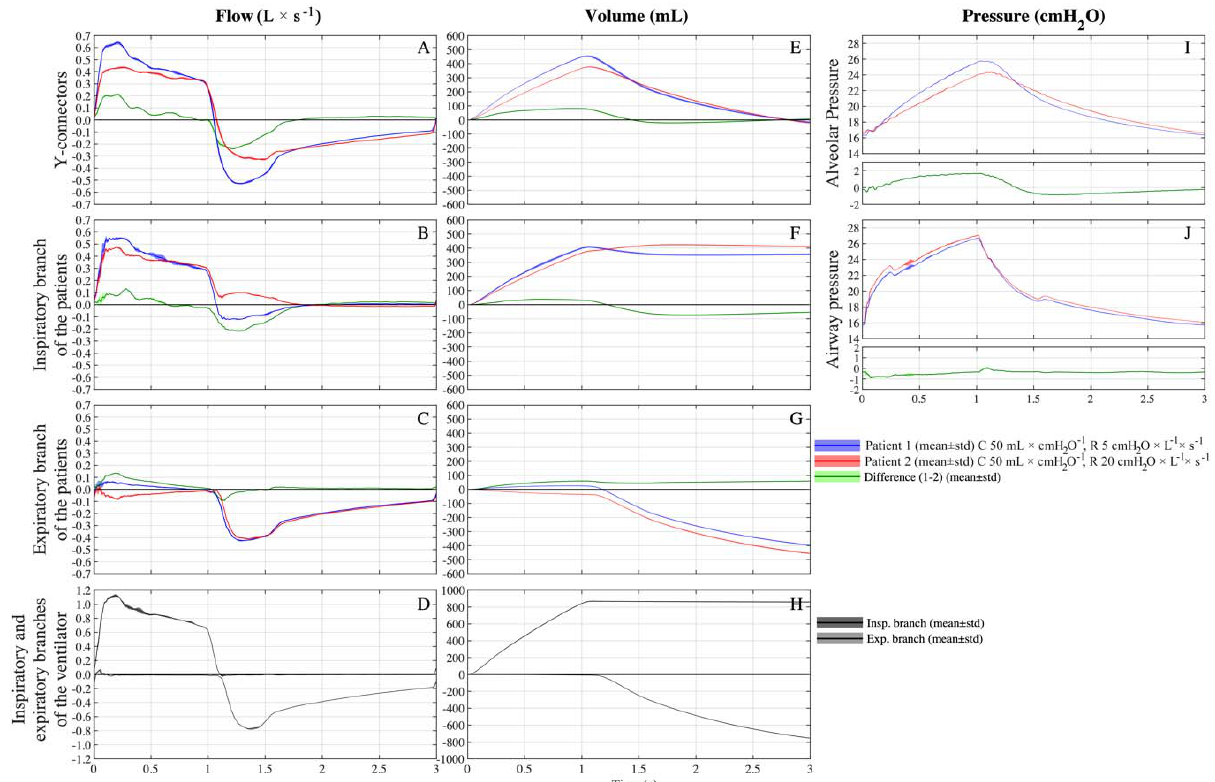
Figure 3. Average (continuous line) ± standard deviation (filled area plot) of multiple breaths of flows, pressures and volumes across the custom-made circuit on setting C 50-50/R 5-20 (C = 50 mL × cmH 2 O − 1 for both patients, R = 5 cmH 2 O × L − 1 × s − 1 for patient 1 and R = 20 cmH 2 O × L − 1 × s − 1 for patient 2). Blue = patient 1, red = patient 2; green = difference between patient 1 and 2; dark grey = inspiratory branch of the ventilator, light grey = expiratory branch of the ventilator. ( A ) Flows at Y-connectors. ( B ) Flows at inspiratory branch of patients. ( C ) Flows at expiratory branch of patients. ( D ) Flows at inspiratory and expiratory branches of ventilator. ( E ) Volumes at Y-connectors. ( F ) Volumes at inspiratory branch of patients. ( G ) Volumes at expiratory branch of patients. ( H ) Volumes at inspiratory and expiratory branches of ventilator. ( I ) Alveolar pressures. ( J ) Airways pressures at HME.